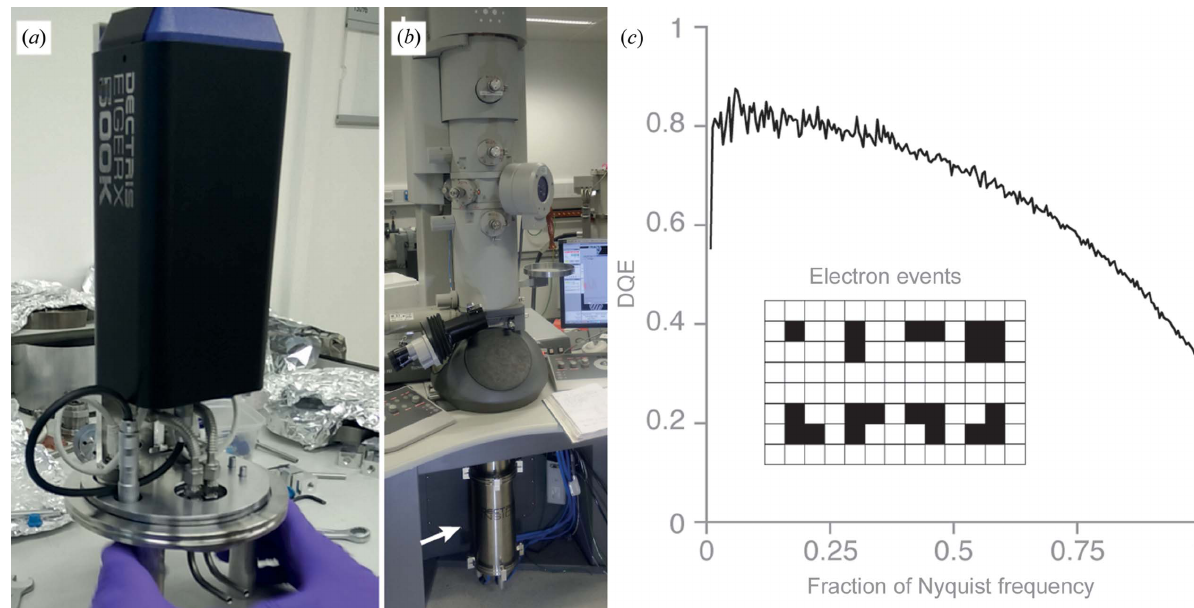
Figure 1 Hybrid pixel detector for data collection at 100 keV. ( a ) shows the EIGER X 500K camera mounted on the ISO160-K flange. ( b ) shows the vacuum enclosure containing the detector fitted to the bottom of the projection chamber of an FEI TF20. ( c ) shows the measured detective quantum efficiency (DQE) of the detector versus spatial frequency (fraction of the Nyquist frequency) at 100 keV. The inset shows the events that are observed with a threshold of 6.5 keV (with probability greater than 0.01%) in images that have less than one incident 100 keV electron per 1000 pixels. The relative probabilities for an electron to be recorded in one, two, three or four pixels are 0.257, 0.520, 0.140 and 0.081, respectively. This distribution for recording incident electrons gives an average response per electron of 2.0 counts and an upper bound for DQE(0) of